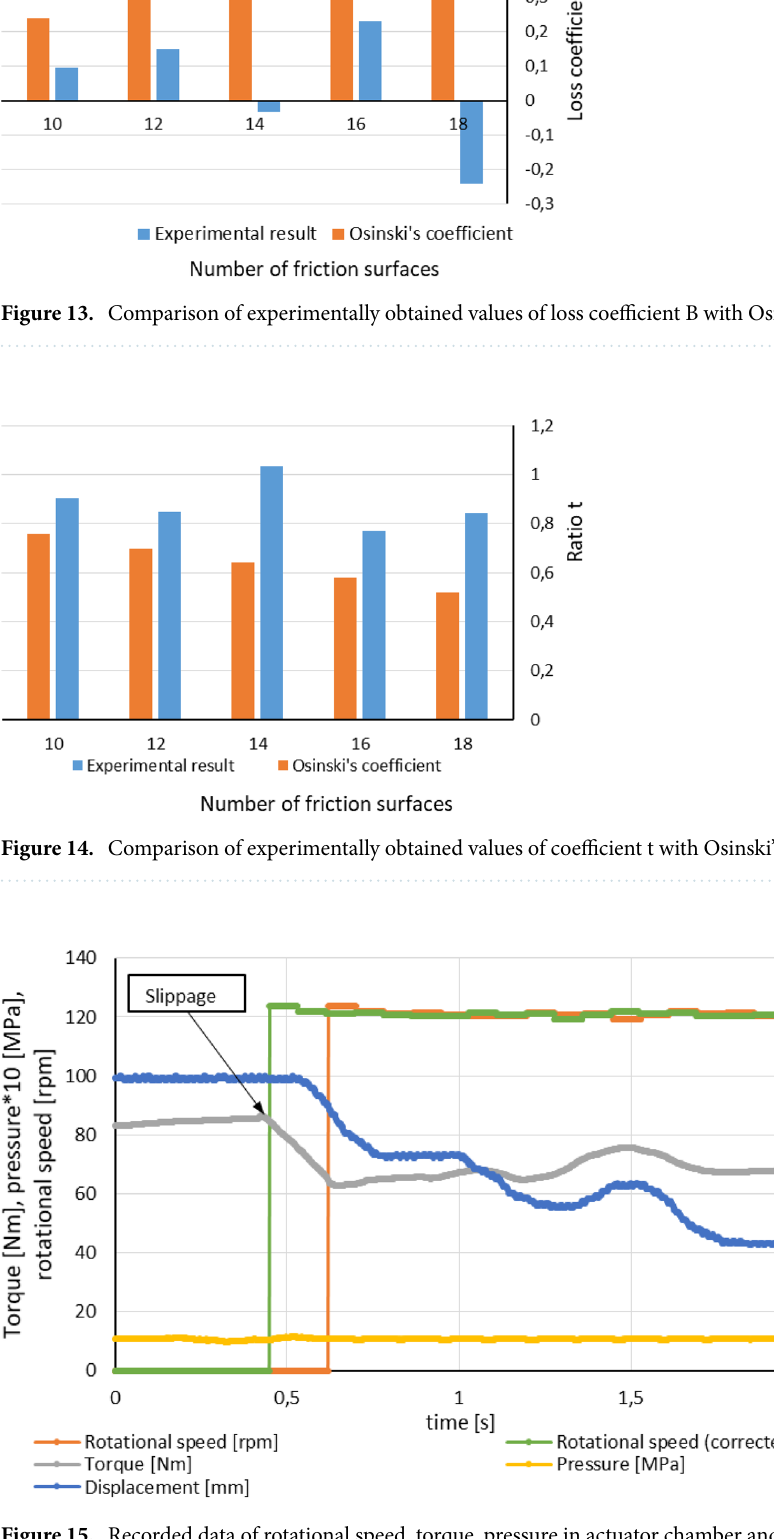
Figure 15. Recorded data of rotational speed, torque, pressure in actuator chamber and displacement presenting increased displacement of discs package after clutch